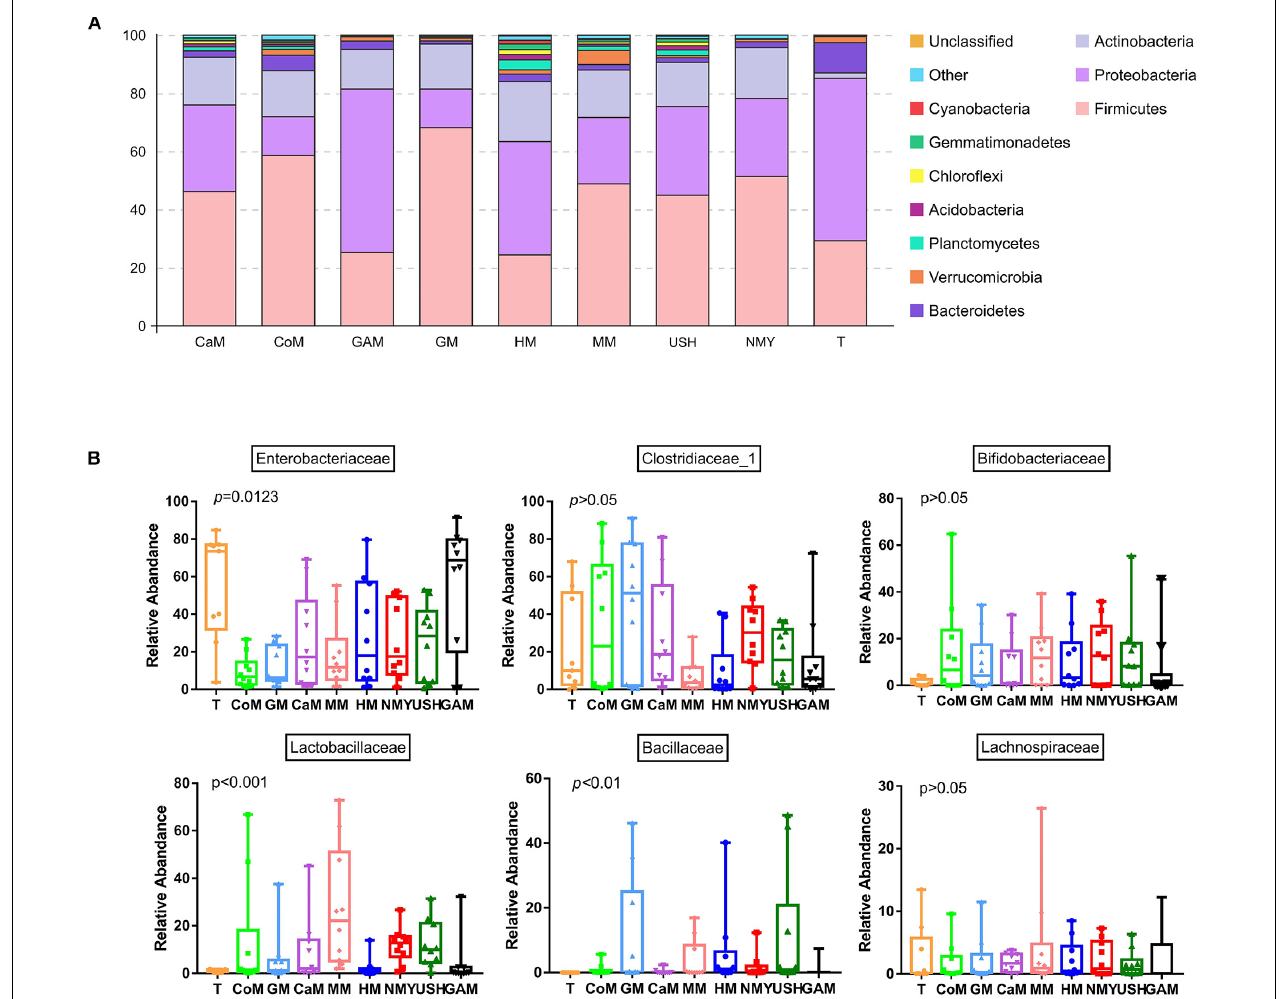
FIGURE 4 | Microbial relative abundance in different kinds of milk fermented with infant fecal slurry. The capital letters on the various graphs signify: (A) phyla level; (B) dominant bacteria of a family level. T, initial infant fecal slurry of ten infants; NMY and USH, infant formula powder; CoM, cow milk; GM, goat milk; CaM, camel milk; MM, mare milk; HM, human milk; GAM, Gifu anaerobic